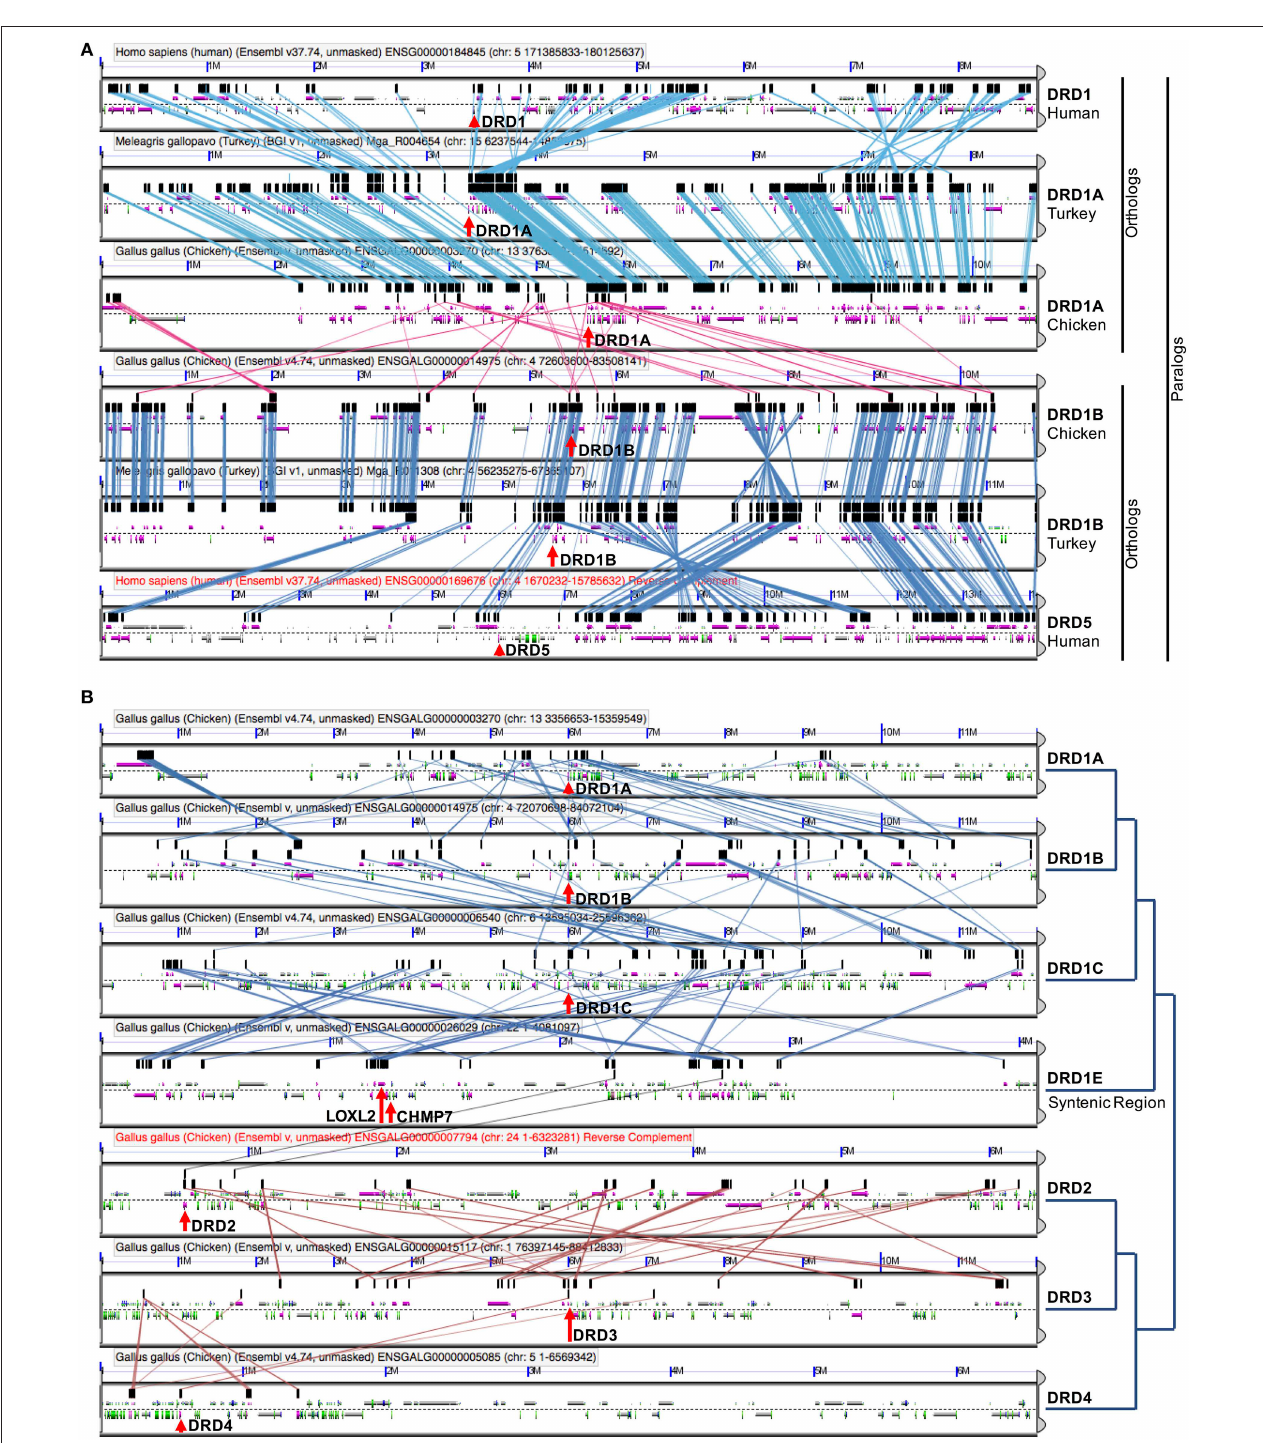
FIGURE 4 | DA receptor microsynteny analysis. (A) Visualization of shared microsynteny between human, chicken, and turkey chromosome regions containing DRD1A (human DRD1) and DRD1B (human DRD5) receptors. Strong synteny can be seen between Turkey/Chicken DRD1A receptors and Turkey/Chicken DRD1B receptors. Human chromosome regions containing DRD1 and DRD5 receptors show clear synteny with respective orthologs containing chicken and turkey chromosome regions. Chicken DRD1A and DRD1B regions show synteny with one another, although the signal is weaker than between orthologous receptors in different species. (B) Microsynteny visualizations (left) and phylogenetic relationships (right) of all DA receptors in Chicken. Microsynteny can be observed between D1 receptors, with the strongest between DRD1A and DRD1B. No pattern of microsynteny is seen between the two classes of receptors, with weak synteny seen between DRD2 and DRD3. Details on how to read these microsynteny analyses are described in Figure 3 . Results can be regenerated at (A) https://genomevolution. org/r/ho6d and (B) http://genomevolution.org/r/hjp0.